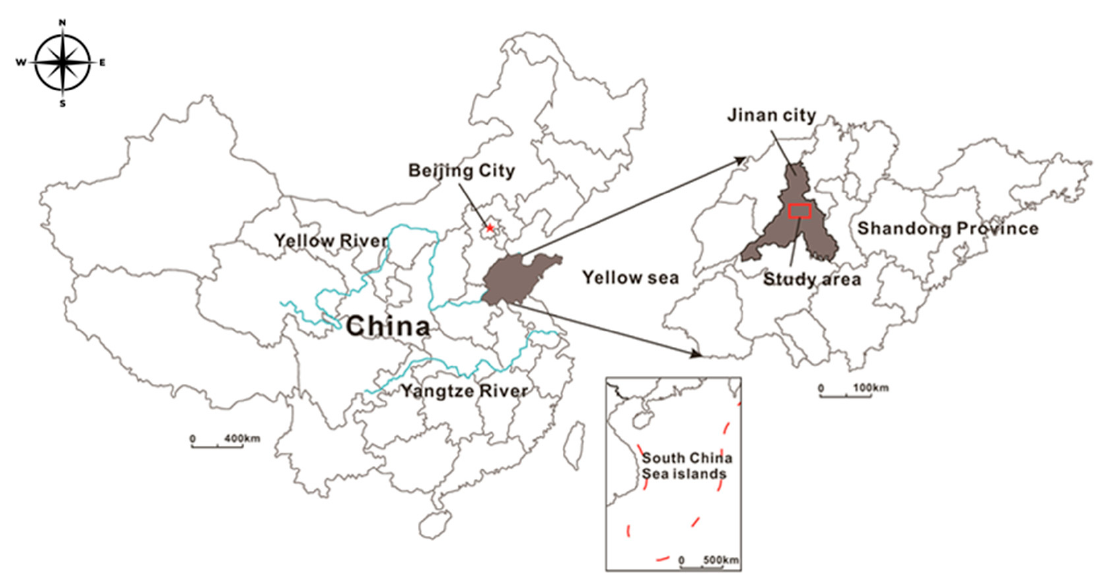
Figure 1. Location of study area.